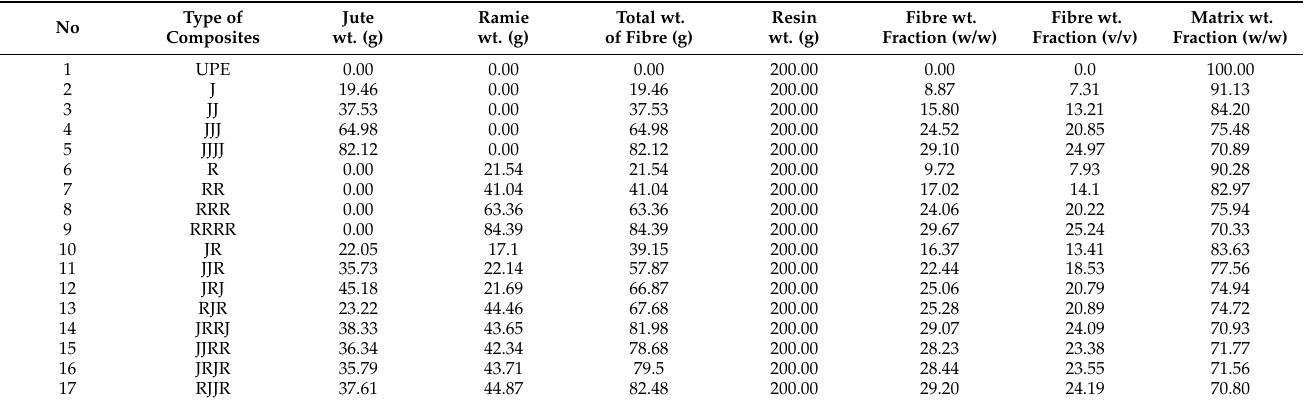
Table 2. Design of hybrid jute–ramie reinforced unsaturated polyester